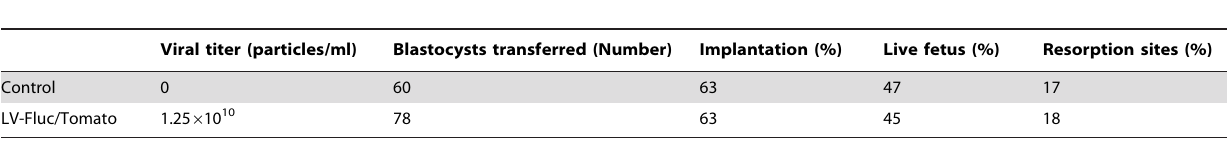
Table 1. Effect of lentivirus transduction (LV-Fluc/Tomato) into blastocysts and live bioluminescence imaging on pregnancy